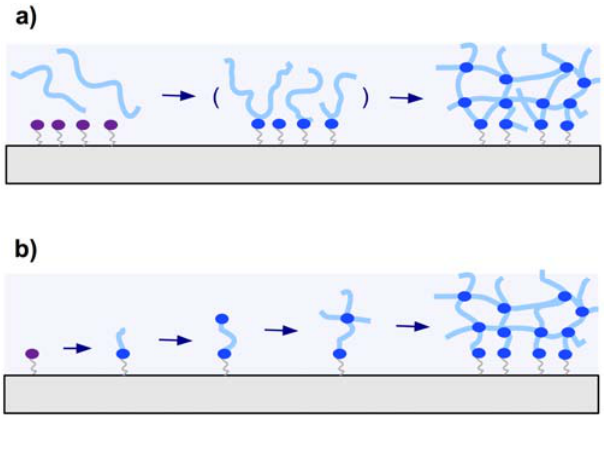
Figure 5. Schematic representation of ( a ) the “grafting to” and ( b ) the “grafting from”